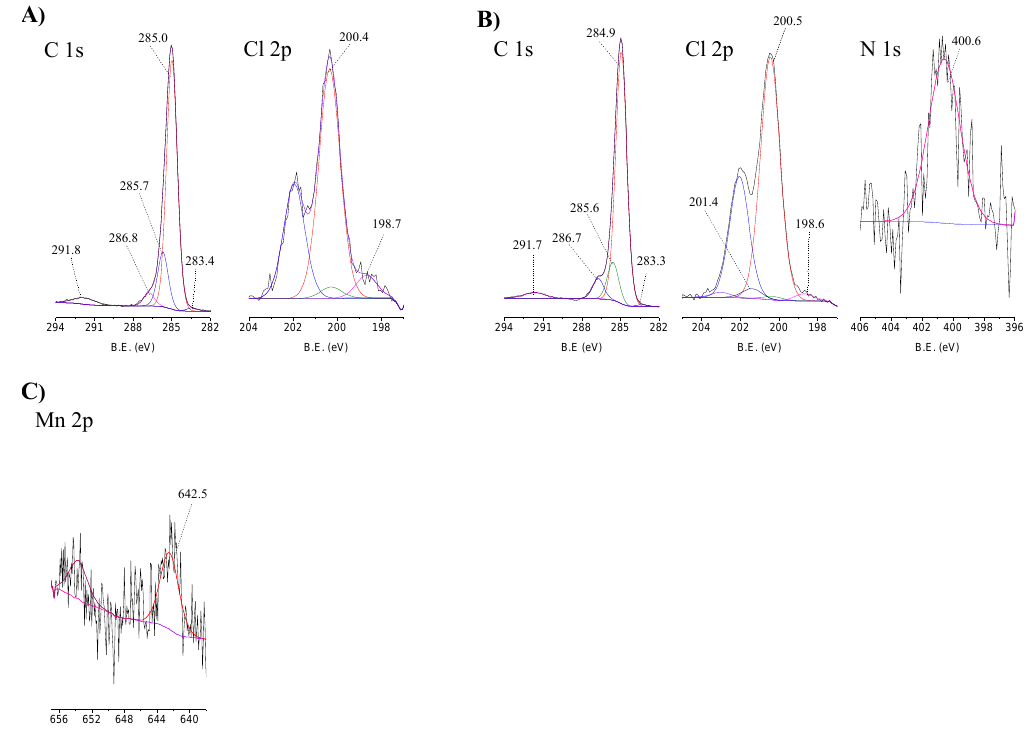
Figure 6. High-resolution XPS spectra in the relevant regions with the corresponding fits for ( A ) MR, ( B ) CAT-4-MR and ( C ) CAT-5-MR .